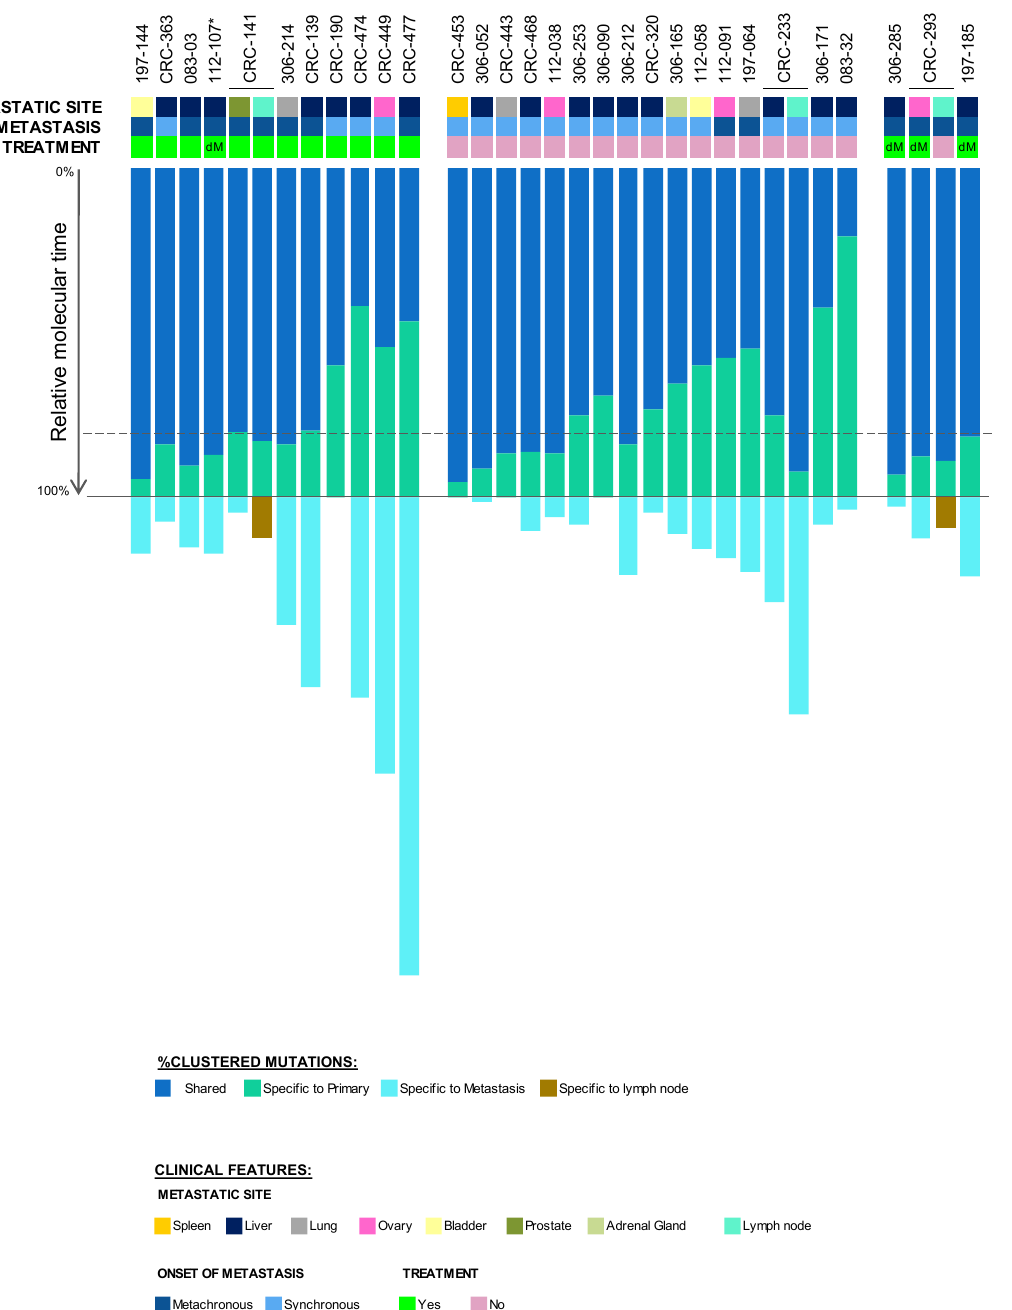
Figure 3. Relative metastatic divergence in metastatic colorectal cancer cohort. %Final molecular time at primary tumour (or lymph node metastasis, where relevant), before dissemination to the metastatic site (local and / or distant), for 30 patients. The dashed line represents the median %final molecular time (79.6%) at the primary tumour. The metastatic site, onset of metastasis, and treatment of each tumour is shown in the panel above. “dM” represents distant metastasis. The treatment status of the primary tumour of patient 112-107, marked by an asterisk (*), was not